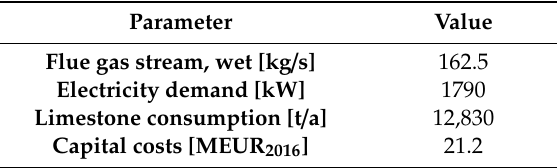
Table A6. Parameters description FGD